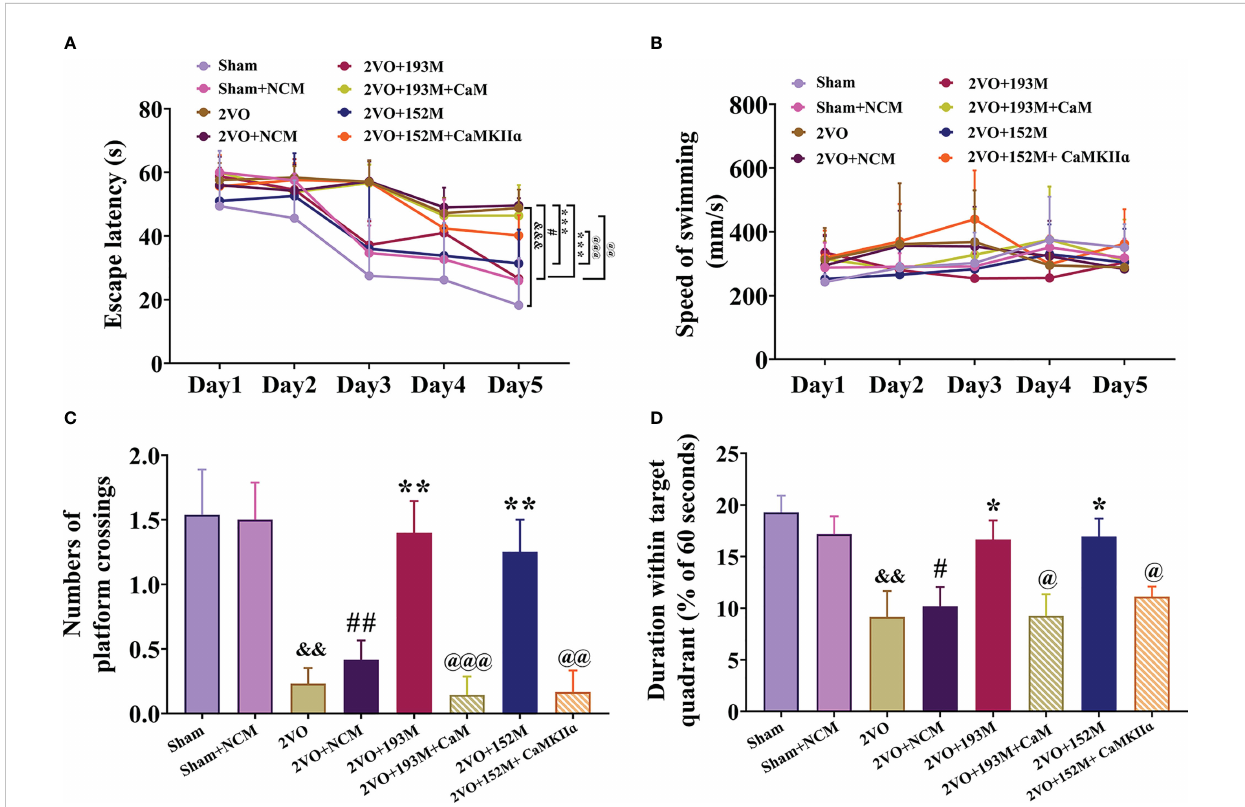
FIGURE 6 miR-193b-3p and miR-152-3p attenuated cognitive decline in VaD model rats by targeting CaM and CaMKII ɑ . (A) Escape latency in the Morris water maze navigation test. (B) Swimming speed. (C) Number of platform crossings. (D) Duration spent within the target quadrant. Results represent the mean ± SD, n =8, && P <0.01, &&& P <0.001 vs. sham, # P <0.05, ## P <0.01 vs. sham+NCM, * P <0.05, ** P <0.01, *** P <0.001 vs. 2VO+NCM, @ P <0.05, @@ P <0.01, @@@ P <0.001 vs.